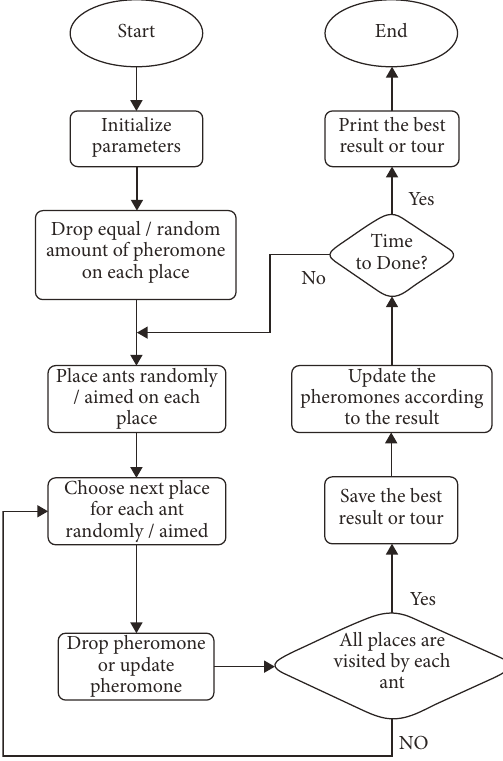
Figure 3: AntHocNet routing in aerial networks.